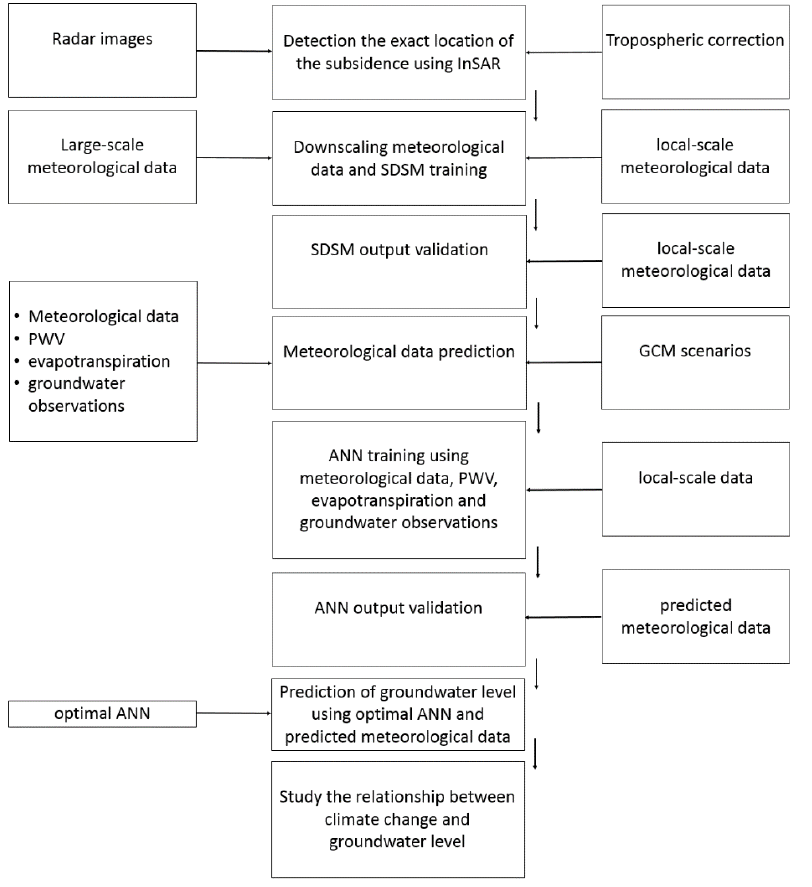
Figure 6. Processing steps of this study